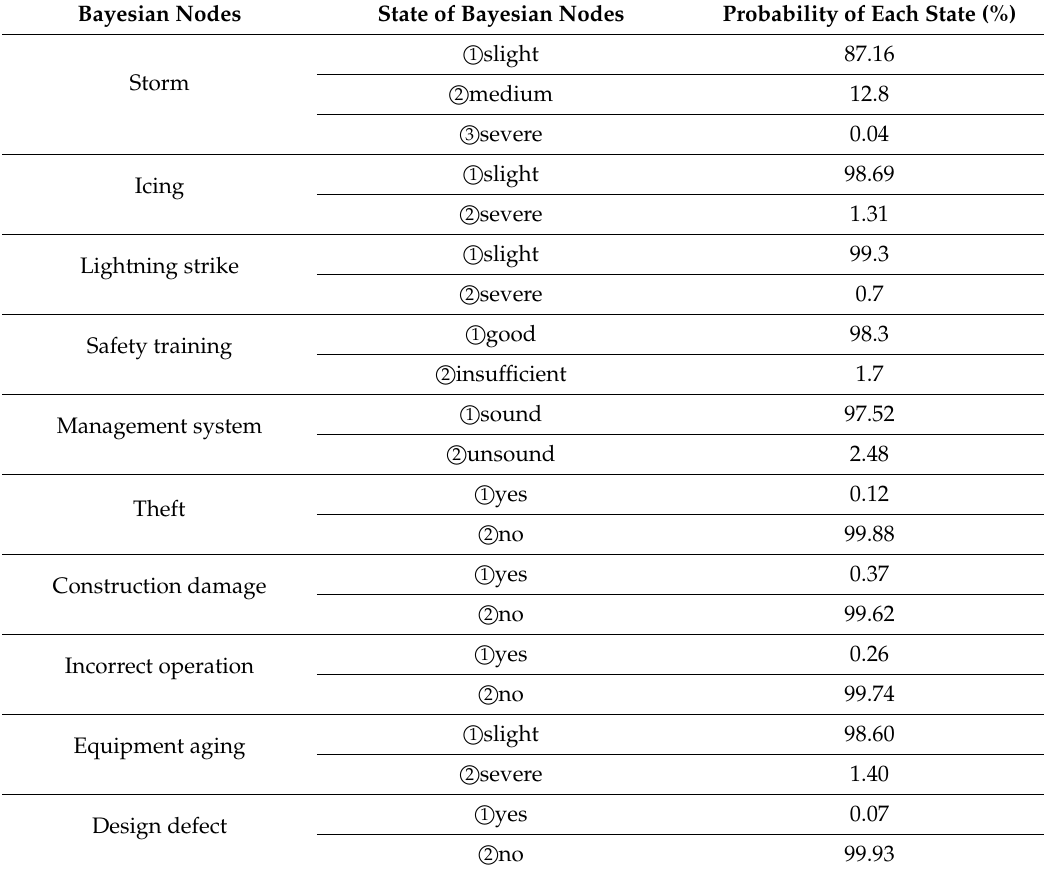
Table 1. Probability of parent